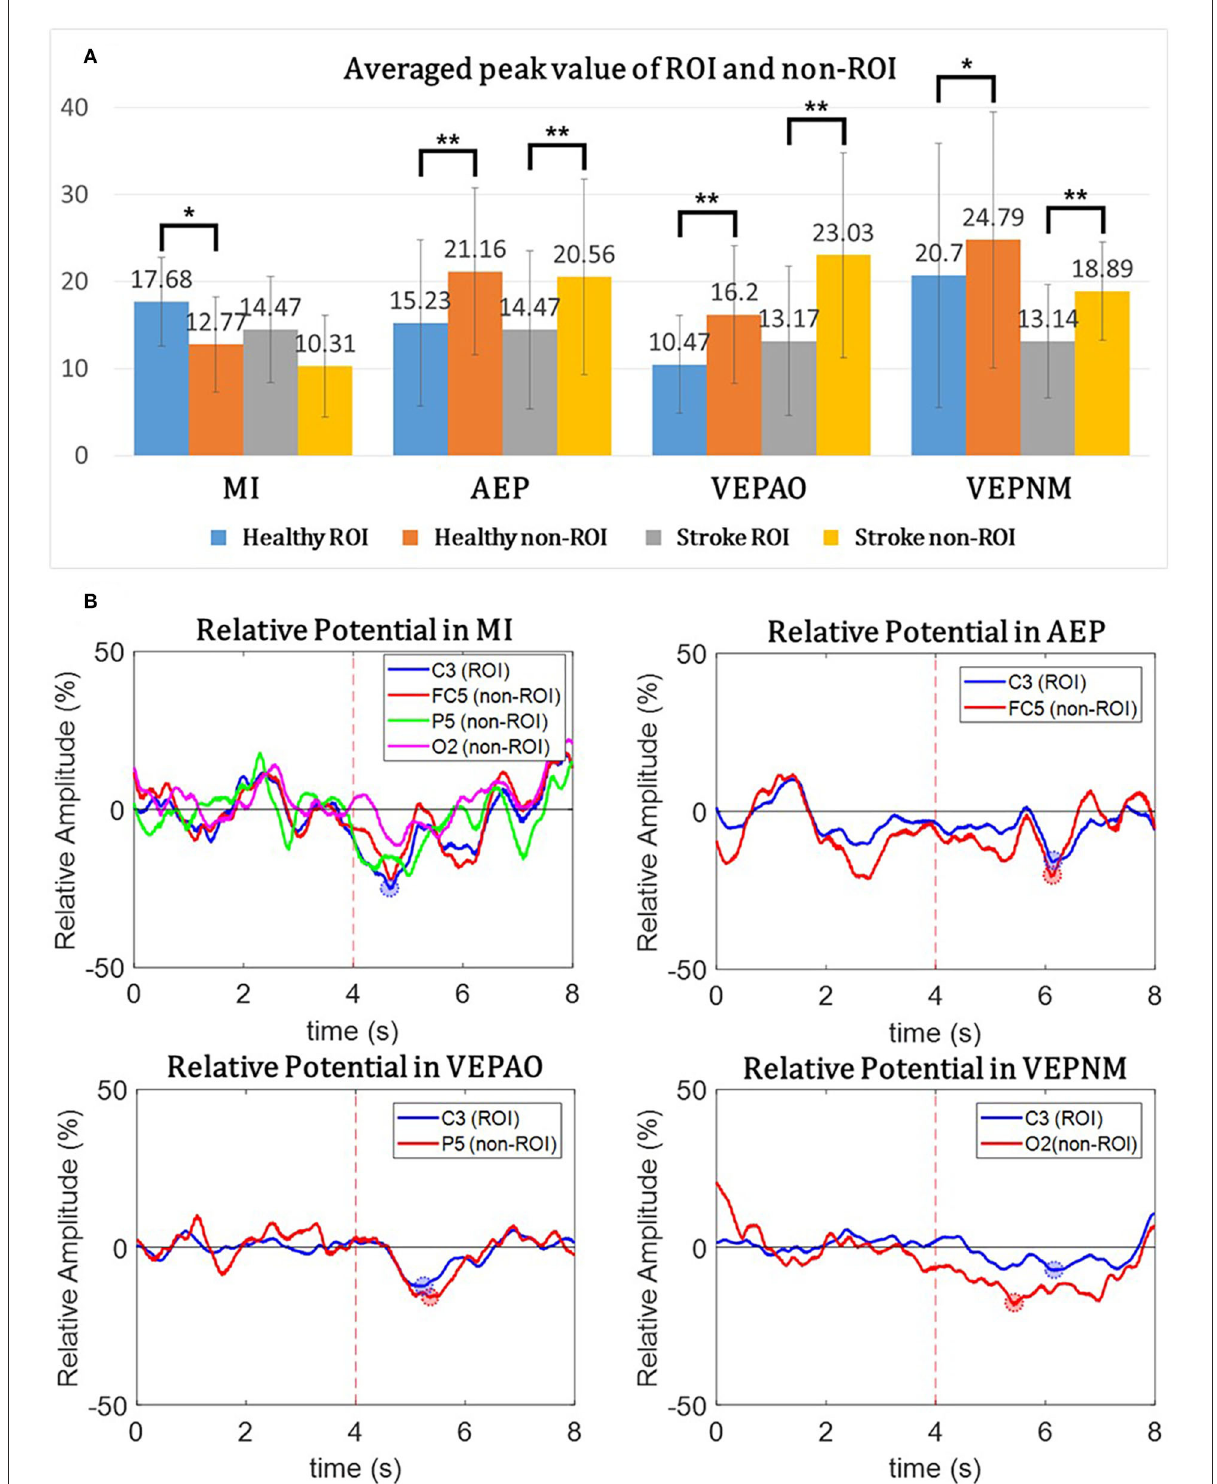
FIGURE7 The relative potential from the region of interest (ROI) and non-ROI candidate channels, and the mean peak value of overall participants. (A) The average peak value of the ROI and non-ROI candidate channels for each participant group during each paradigm. The paired t-test is performed between the ROI and non-ROI candidate channels. Statistically mild significance (p < 0.08) is described using a single asterisk (*) and statistical significance ( p < 0.05) using a double asterisk (**). The candidates of the non-ROI channel for the MI paradigm are an average of three different non-ROI candidate channels. (B) The relative potential of the characteristic participant. The blue line represents the data of the ROI channels, and the red line represents the data from the non-ROI candidate channels. VEPAO, VEP with action observation; VEPNM, non–motor-related